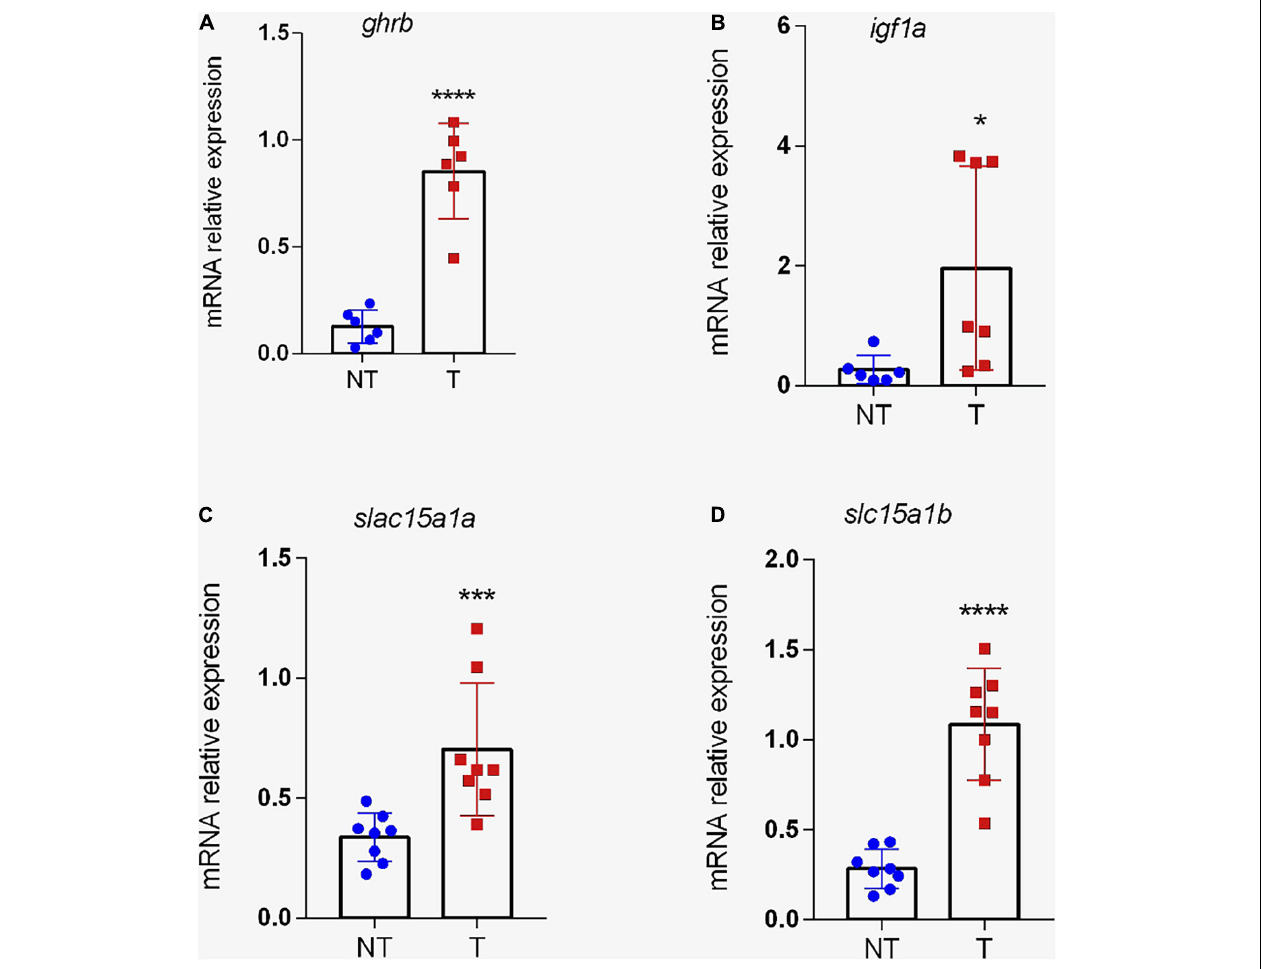
FIGURE 6 | Expression of genes related to growth and peptide transport in the intestine of transgenic zebrafish ( D. rerio ). Relative ghrb (A) , igf1a (B) , slc15a1a (C) , and slc15a1b (D) gene expression normalized against eef1 α and rpl13a in intestine from non-transgenic and gh -transgenic zebrafish. The transgenic group shows a significant increase in mRNA expression of ghrb , igf1a, and for the two genes that encode to PEPT1 transporter ( slc15a1a and slc15a1b) . The differences in relative mRNA expression between the two groups were determined using a two-tailed t -test. Data are shown as mean ± SD. Asterisks indicate significant differences (* p < 0.05, *** p < 0.001; and **** p < 0.0001). NT, non-transgenic; T,